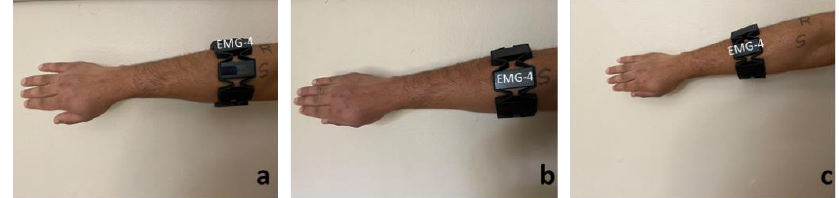
Figure 3. Three armband sensor positions to test the effect of sensor position on data quality: ( a ) rotated, ( b ) standard, and ( c ) slid down.